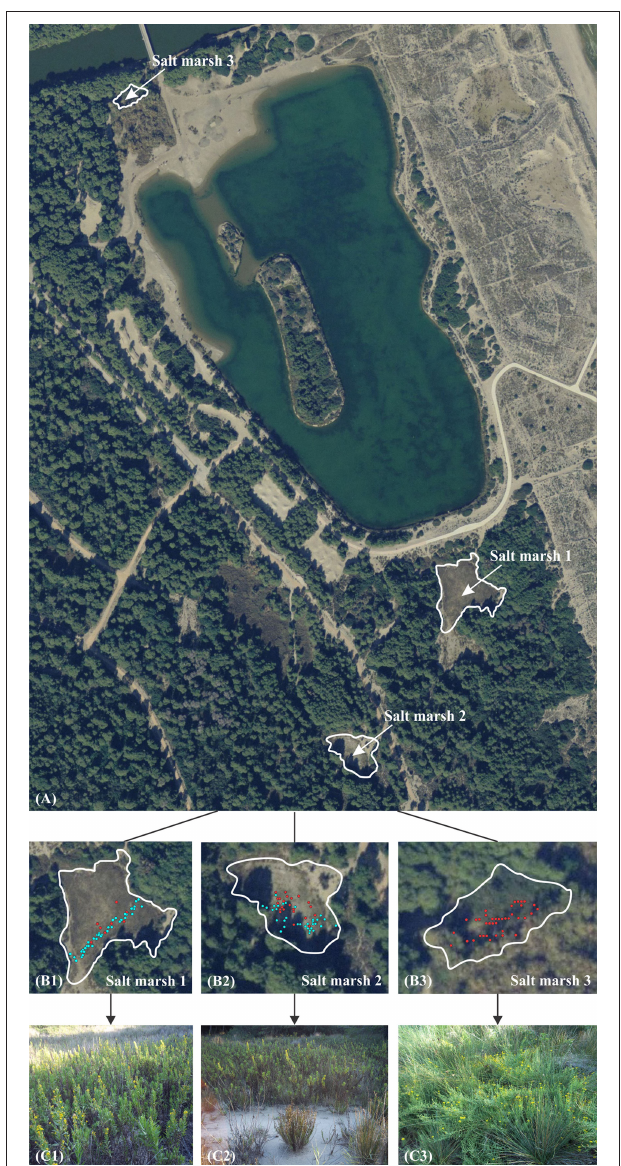
FIGURE 1 | General view of the area in “La Albufera” Natural Park where the field work was carried out, with the location of the three selected salt marshes (A). Distribution of the two species ( Dittrichia viscosa in light blue and Inula crithmoides in red) in salt marsh 1, 2 and 3 ( B1–B3 , respectively). General aspect of the three salt marshes in autumn (C1–C3)